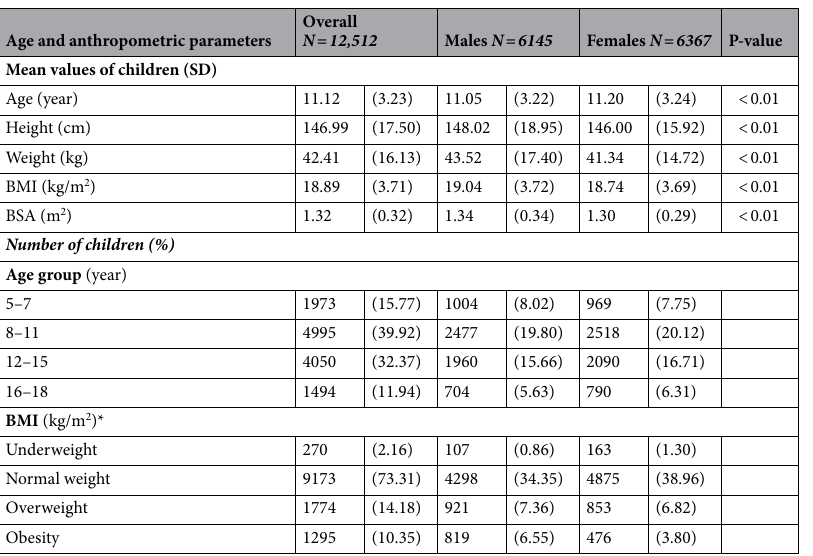
Table 1. Main characteristics of children at time of medical examinations. SD, standard deviation. Means statistically different between males and females are in bold (p-value < 0.05). *Based on the WHO